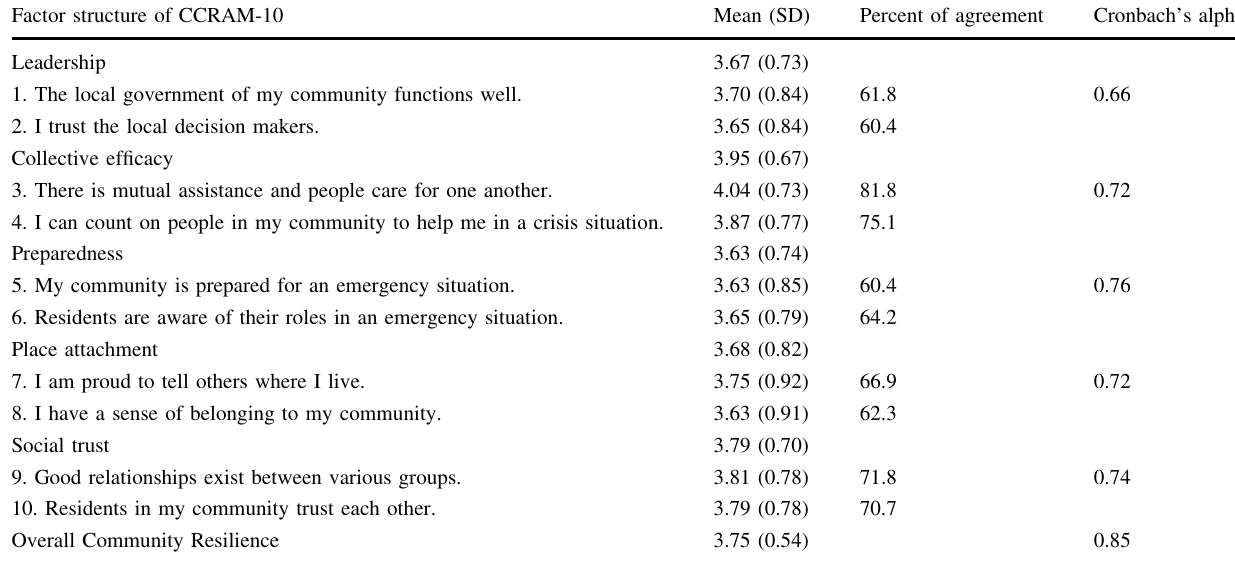
Table 2 Mean, standard deviation, and percentage of agreement with community resilience factors and items of the 10-item Conjoint Com- munity Resilience Assessment Measurement in Aba Prefecture and Chengdu City, southwest China Factor structure of CCRAM-10